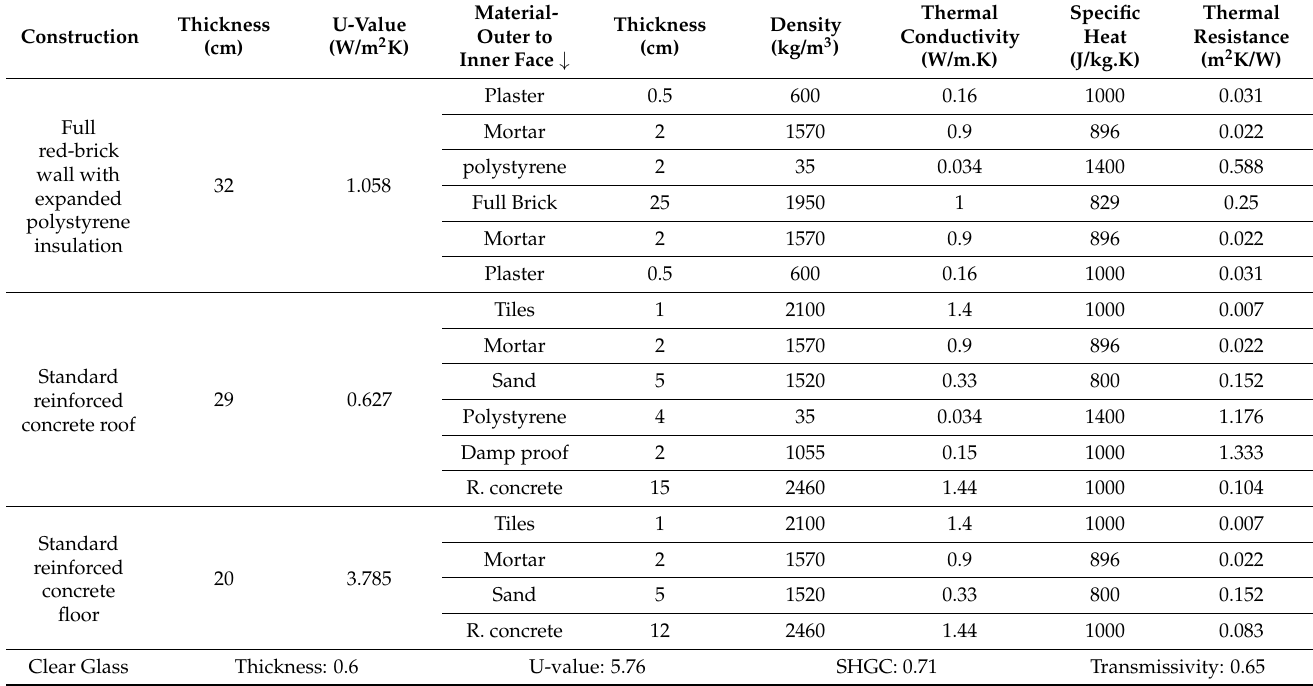
Table A1. Thermal and Physical properties of the construction materials used in the